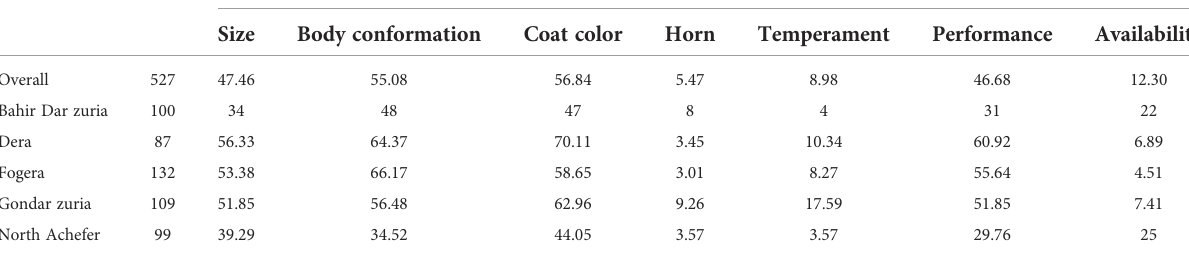
TABLE 7 Weighted proportion for the bull selection criteria.